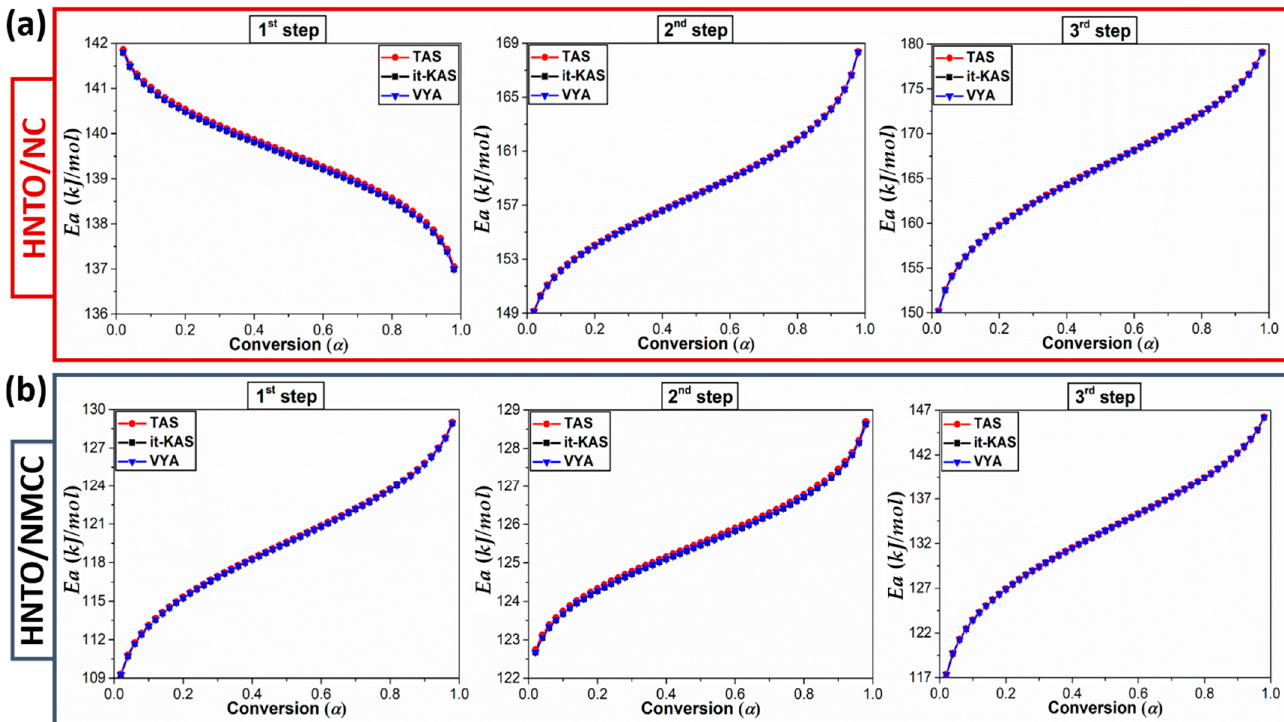
Figure 5. Variation of the activation energy versus the extent of conversion for each decomposition step of ( a ) HNTO/NC composite; ( b ) HNTO/NMCC composite.